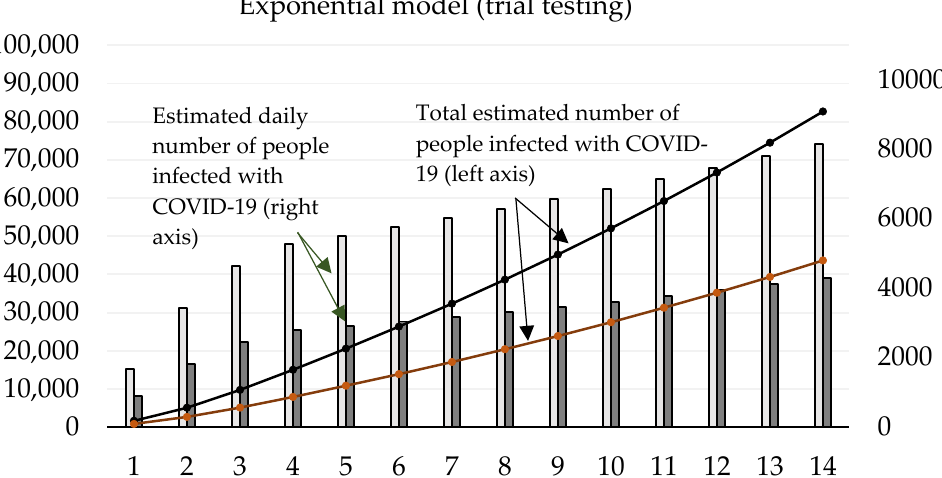
Figure 2. Forecast of the cumulative number of infected people (caused by those who would not be discovered by trial testing) based on the exponential model.